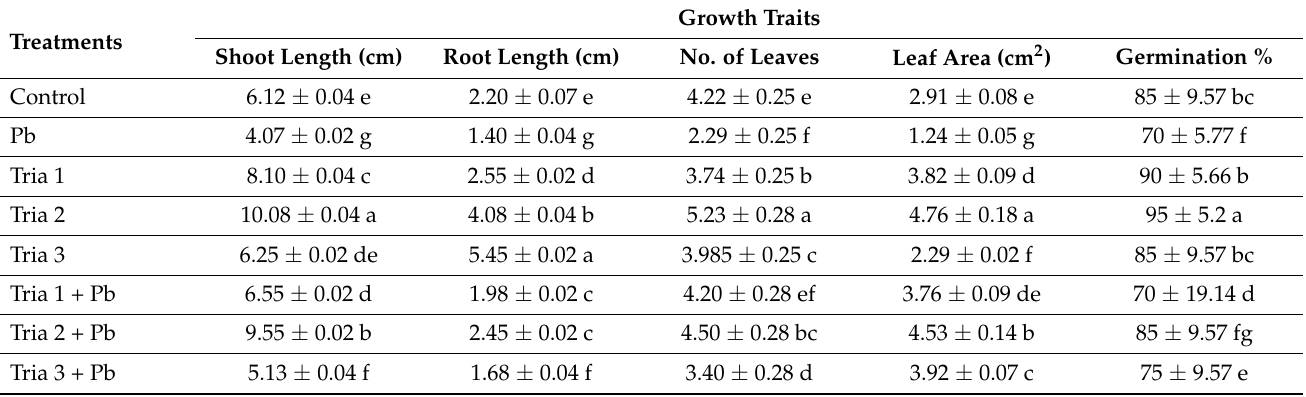
Table 1. Effect of Triacontanol and Pb on Germination and Vegetative growth of Phaseolus vulgaris L.